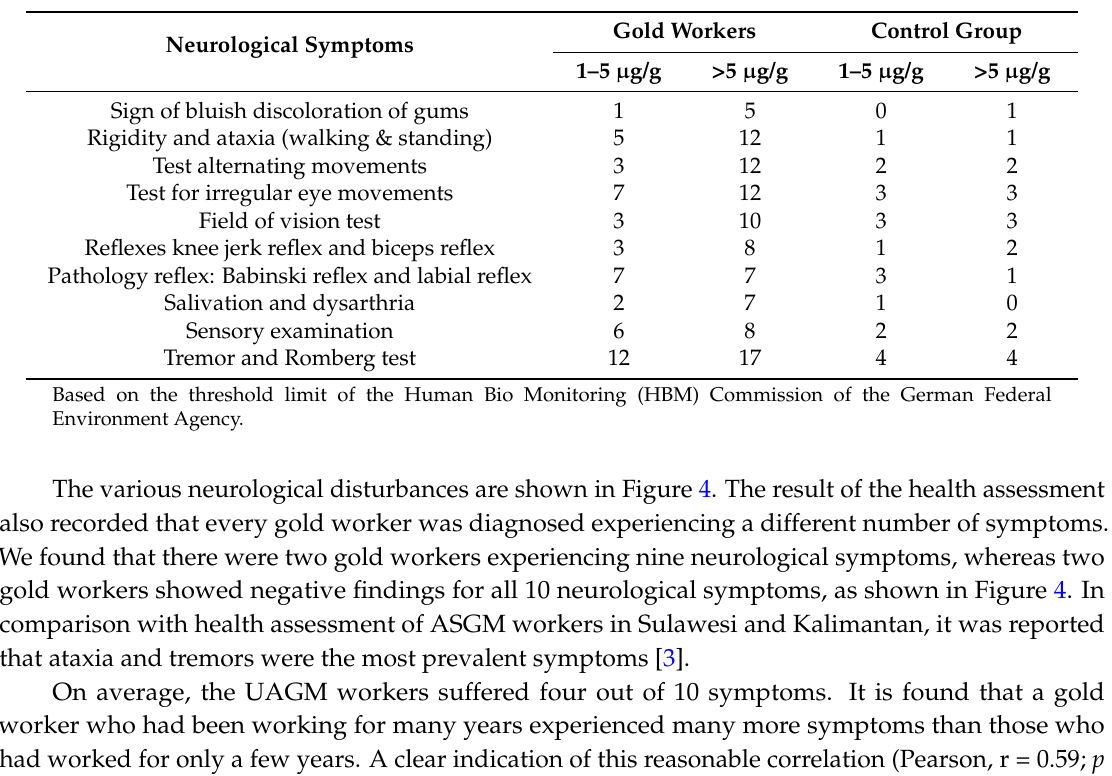
Table 3. Occurrences of the 10 neurological symptoms and mercury level in the gold workers and the control group.